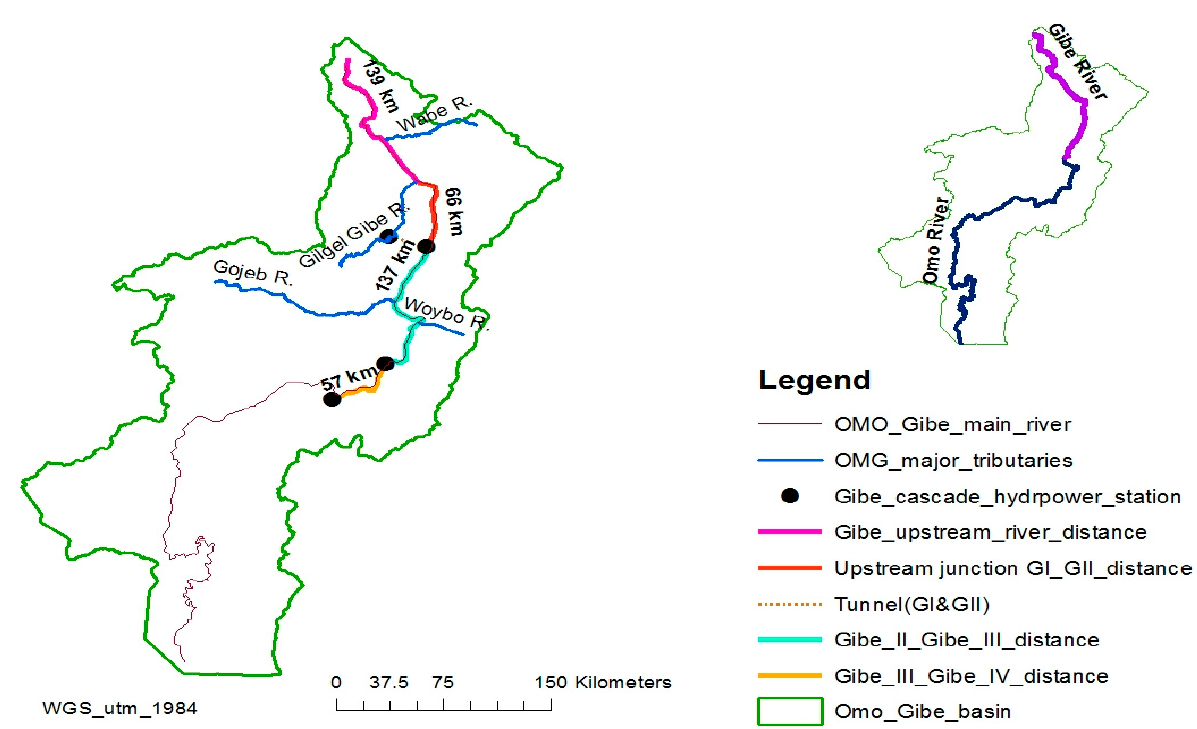
Figure 2. Omo-Gibe River length and tributaries considered in the model.